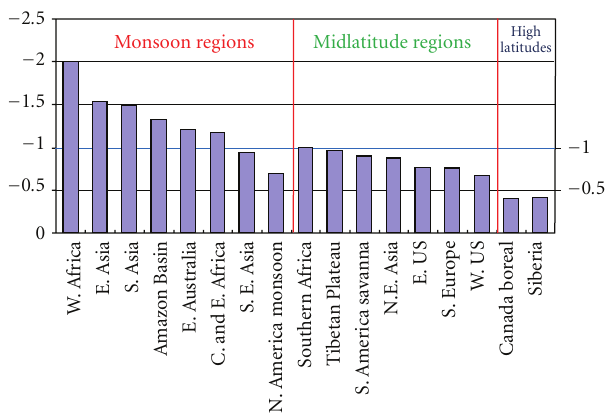
Figure 4: Reduction of absolute annual mean precipitation bias (mmday − 1 ) due to vegetation biophysical processes for di ff erent regions, indicating the impact of vegetation biological process on precipitation [62]. Di ff erences of absolute bias of annual mean precipitation (mmday − 1 ) between LA-VBP and